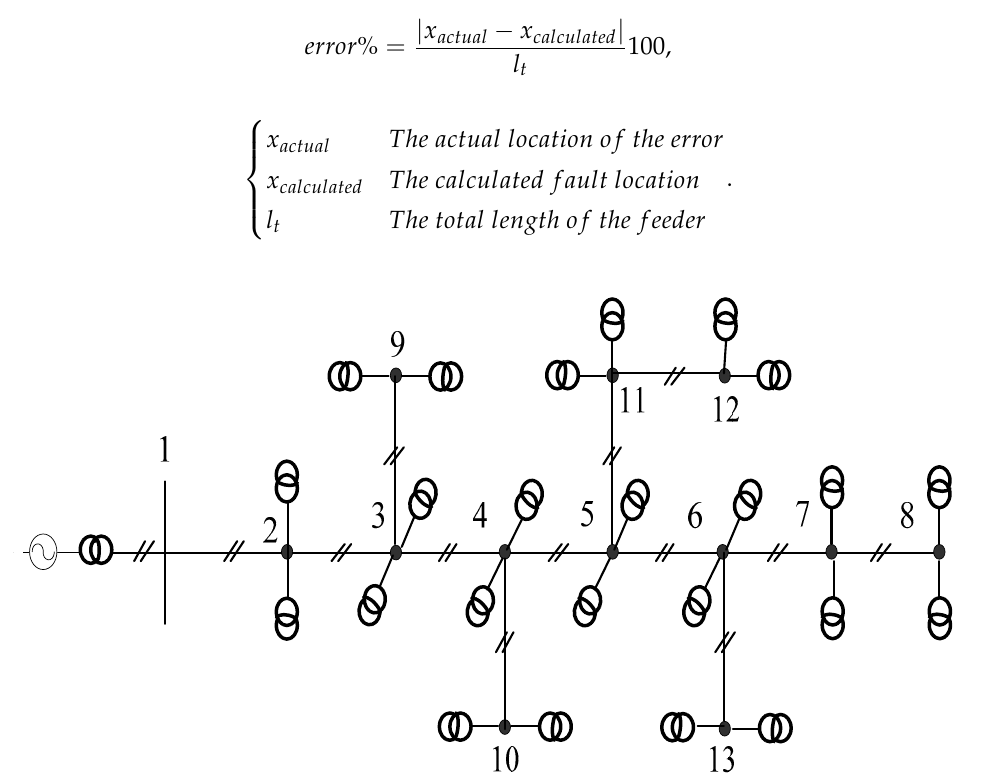
Figure 4. The studied distribution feeder (the numbers is nodes number). Table 2. Length of the lines.